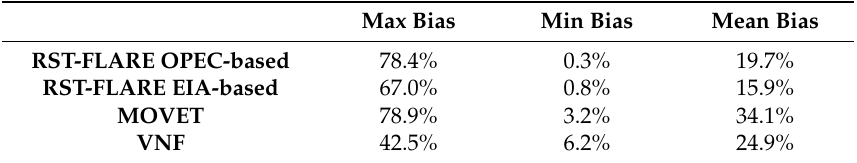
Table 4. Biases between NNPC and RST-FLARE, MOVET and VNF